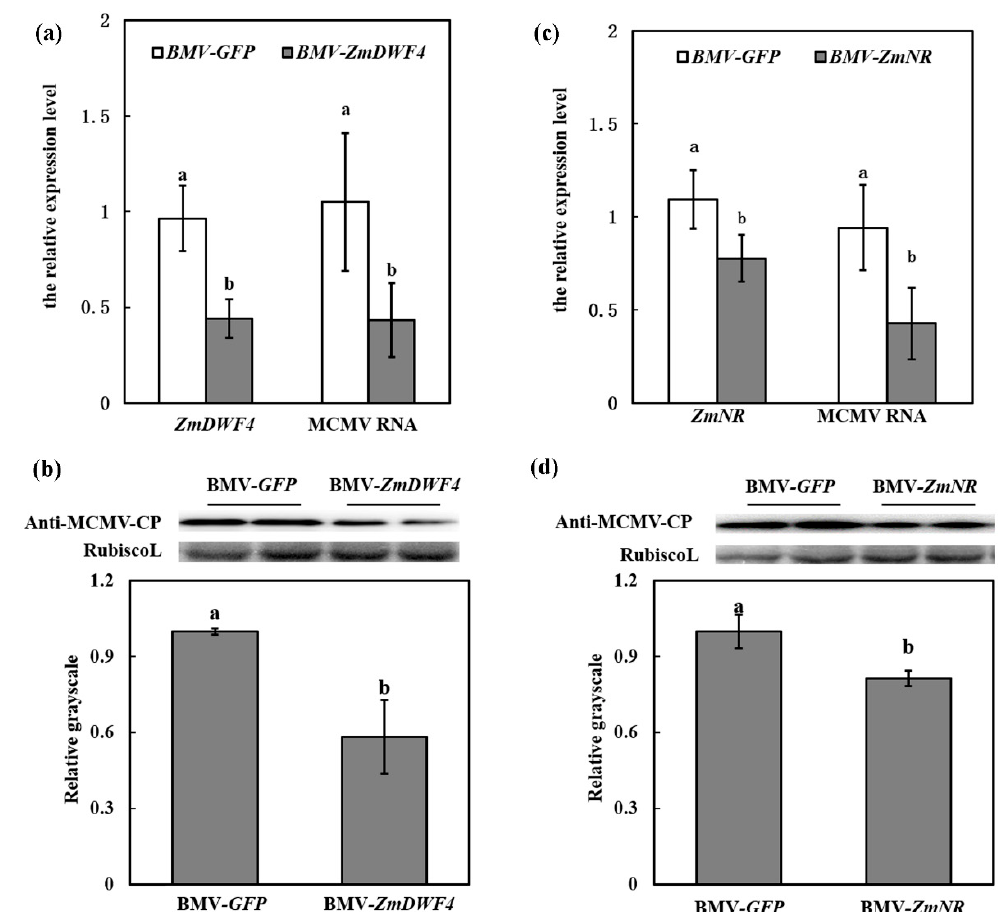
Figure 7. ZmDWF4 / ZmNR silencing inhibited MCMV accumulation. ( a ) RT-qPCR analysis of the accumulation of ZmDWF4 and MCMV RNA in the SL2 of BMV-GFP/MCMV and BMV- ZmDWF4/MCMV plants. ( b ) Representative Western blot indicated MCMV accumulation in the SL2 of BMV- GFP /MCMV and BMV- ZmDWF4 /MCMV plants. The grayscales of immunoblotting bands from three independent experiments were determined by ImageJ. Graphs represent the relative MCMV accumulation through quantifications of three independent experiments with at least three plants per experiment. ( c ) RT-qPCR analysis of the accumulation of ZmNR and MCMV RNA in the SL2 of BMV-GFP/MCMV and BMV- ZmNR /MCMV plants. ( d ) Representative western blot indicated MCMV accumulation in the SL2 of BMV- GFP /MCMV and BMV- ZmNR /MCMV plants. The grayscales of immunoblotting bands from three independent experiments were determined by ImageJ. Graphs represent the relative MCMV accumulation through quantifications of three independent experiments with at least three plants per experiment. Statistical analysis was performed using SPSS 16.0 followed by ANOVA with LSD test at the level of p -value ≤ 0.05. Significant difference between different samples was indicated in lowercase letters.